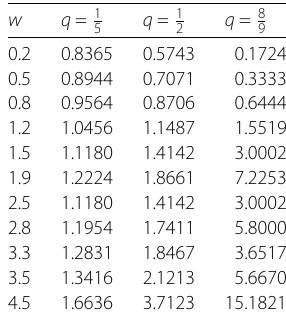
Table 1 Numerical result for (cid:6) q ( w